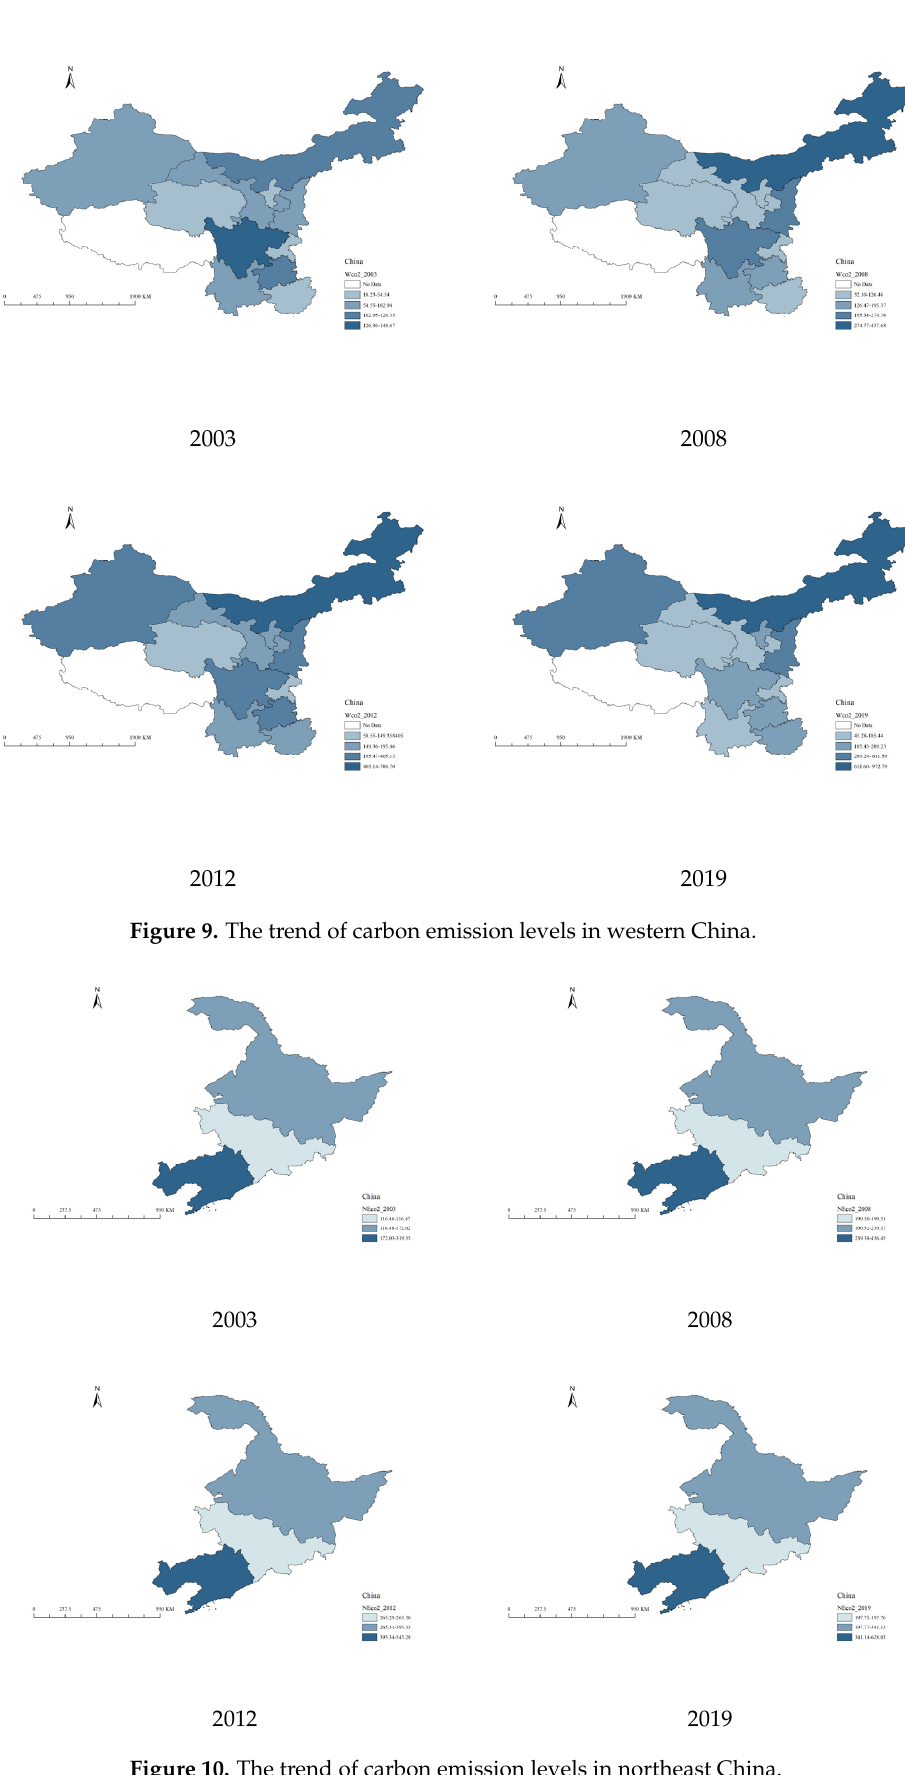
Figure 10. The trend of carbon emission levels in northeast